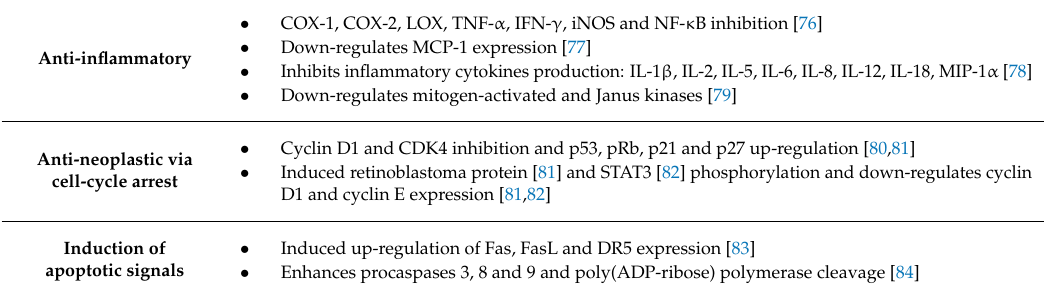
Table 1. Properties and signaling pathways of